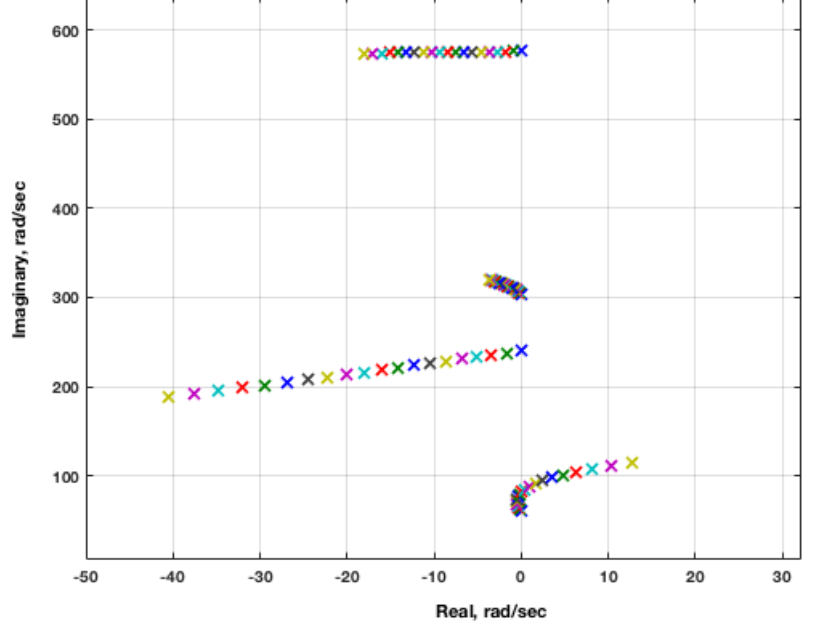
Figure 16. ROM aeroelastic root locus plot for M = 0.96, inviscid